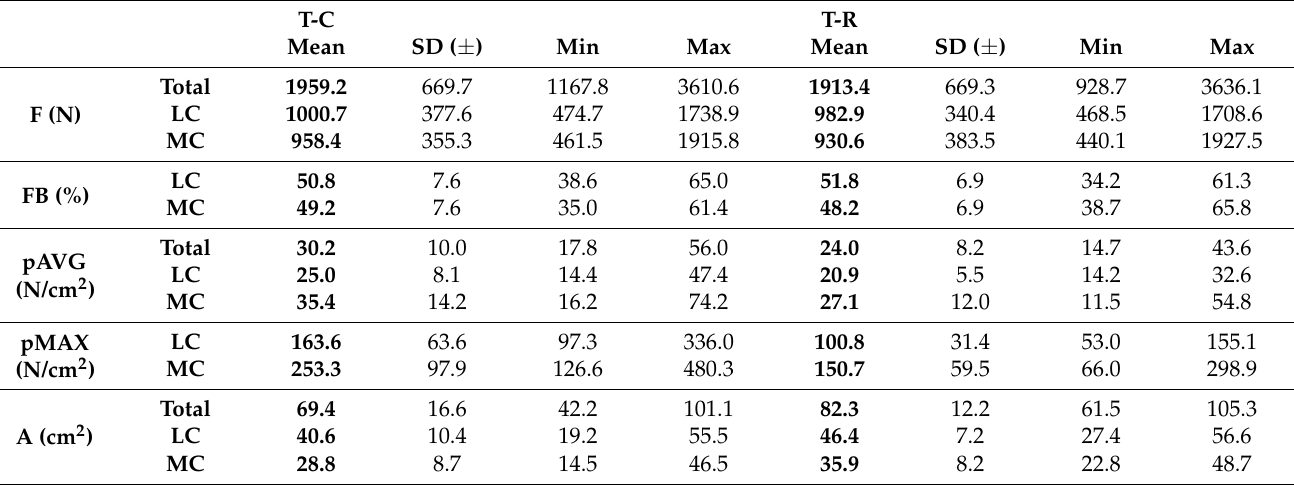
Table 3. Mean pressure data for ten dairy cows in total and differentiated between lateral claw (LC) and medial claw (MC) during trot on concrete (T-C) and rubber mats (T-R).